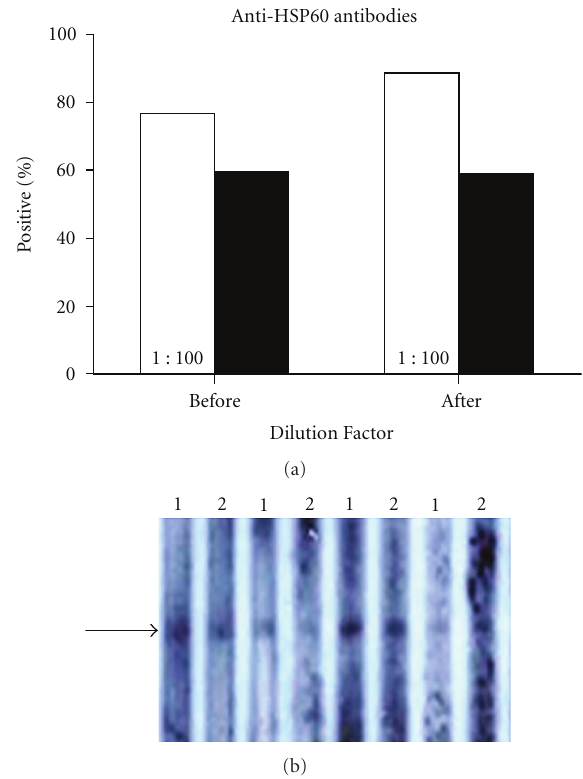
Figure 2: (a) Graph summarizes anti-HSP60 antibody titers before and after intensive treatment. Antibody levels were tested at two di ff erent dilutions: 1 :100 (white bars) and 1 :250 (black bars). (b) Representative slot blot. Arrow marks location of HSP60 on membrane. Lanes were read as positive or negative at a given dilution based on the presence of a band at the level of the arrow, which marks the location of the recombinant human HSP60 on the membrane. 1—1: 100; 2—1 :250.